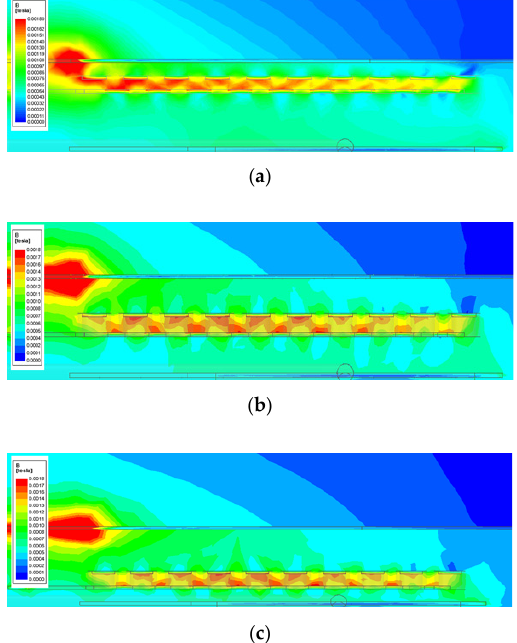
Figure 5. Finite element analysis of coil structure applied to two adjacent inner layers: ( a ) layers 1 and 2; ( b ) layers 2 and 3; and ( c ) layers 3 and 4.